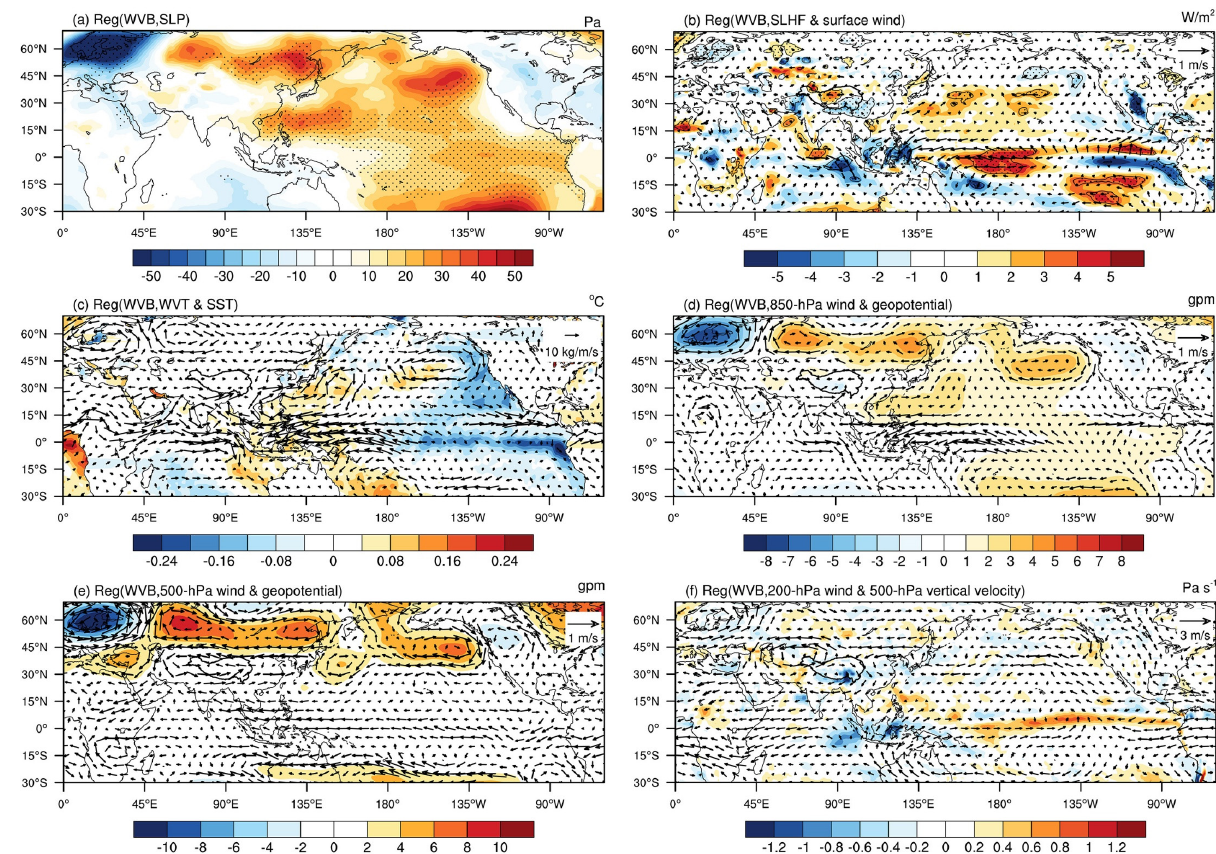
Figure 13. Anomalies of ( a ) sea level pressure (SLP, shadow, unit: hPa), ( b ) SLHF (shadow, unit: W m − 2 ) and surface wind (vector, unit: m s − 1 ), ( c ) water vapor transport flux (vector, unit: kg m − 1 s − 1 ) and SST (shadow, unit: °C), ( d ) horizontal wind (vector, unit: m s − 1 ) and geopotential height (shadow, unit: gpm) at 850 hPa, ( e ) horizontal wind (vector, unit: m s − 1 ) and geopotential height (shadow, unit: gpm) at 500 hPa, ( f ) horizontal wind (vector, unit: m s − 1 ) and vertical velocity (shadow, unit: Pa s − 1 ) at 200 hPa regressed on the detrended and standardized time series of the summer WVB of the TP from 1958 to